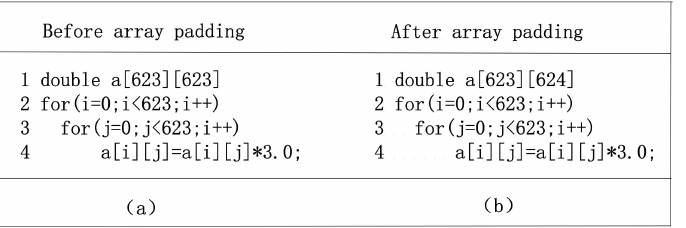
Figure 3. Multidimensional array padding example. ( a ) Before array padding ( b ) After array